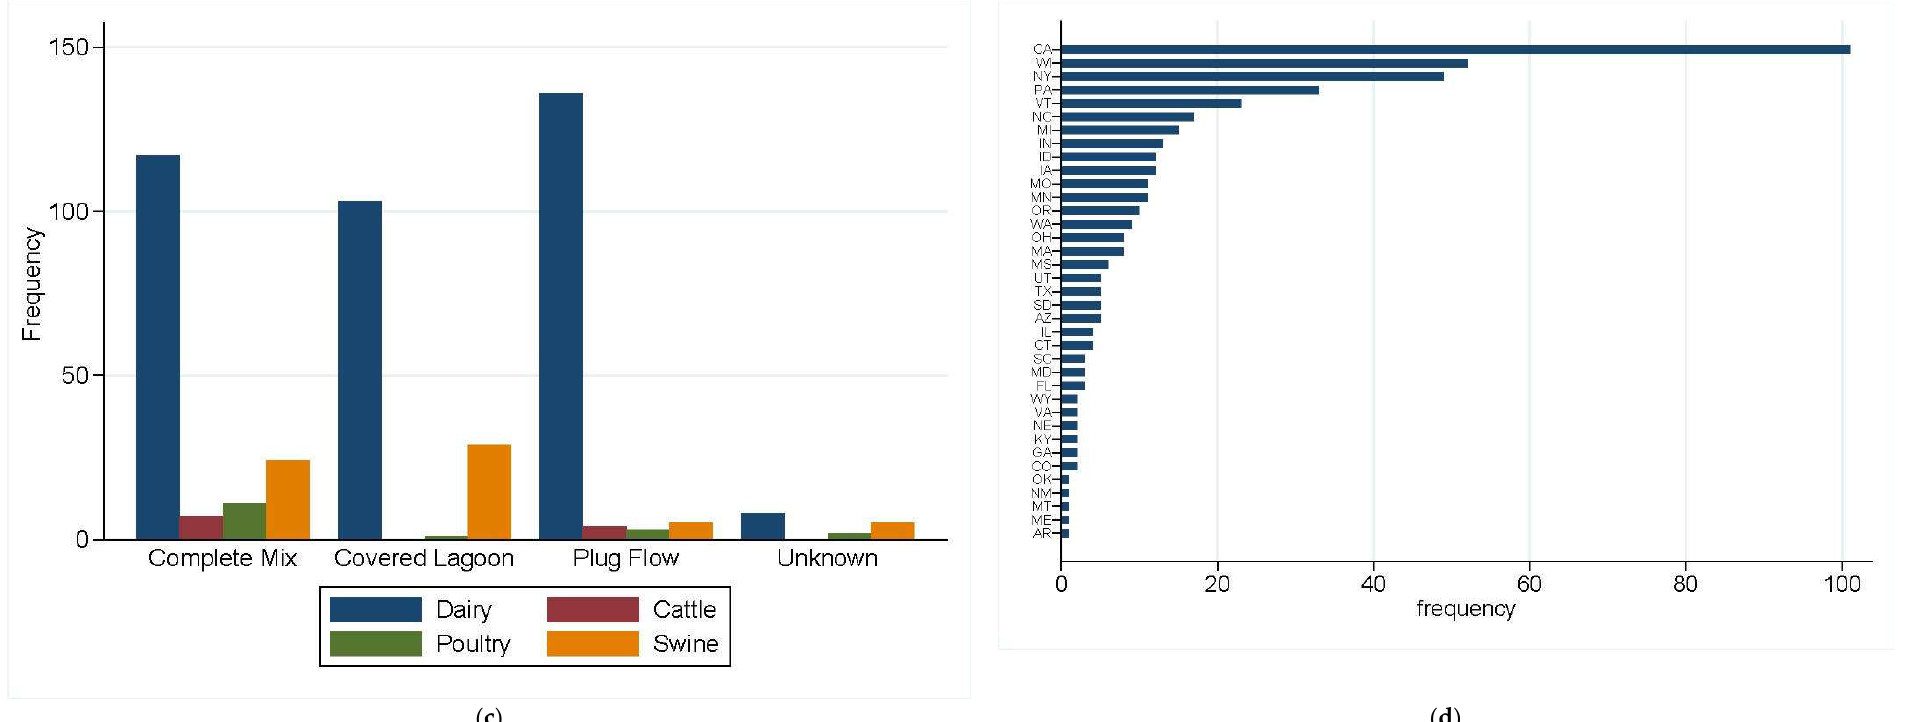
Figure 2. Anaerobic digestion systems registered in the United States for the treatment of animal manure. Frequency of anaerobic digestion facilities by ( a ) operation type; ( b ) year anaerobic digestion facility became operational; ( c ) animal production system (cattle refers to beef cattle); ( d ) State. Data were analyzed from the Agstar livestock AD database [62] .